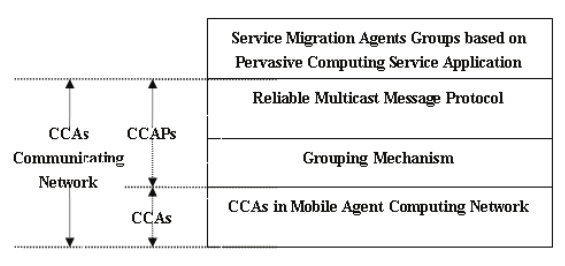
Fig. 2. Architecture of the CCAs communicating